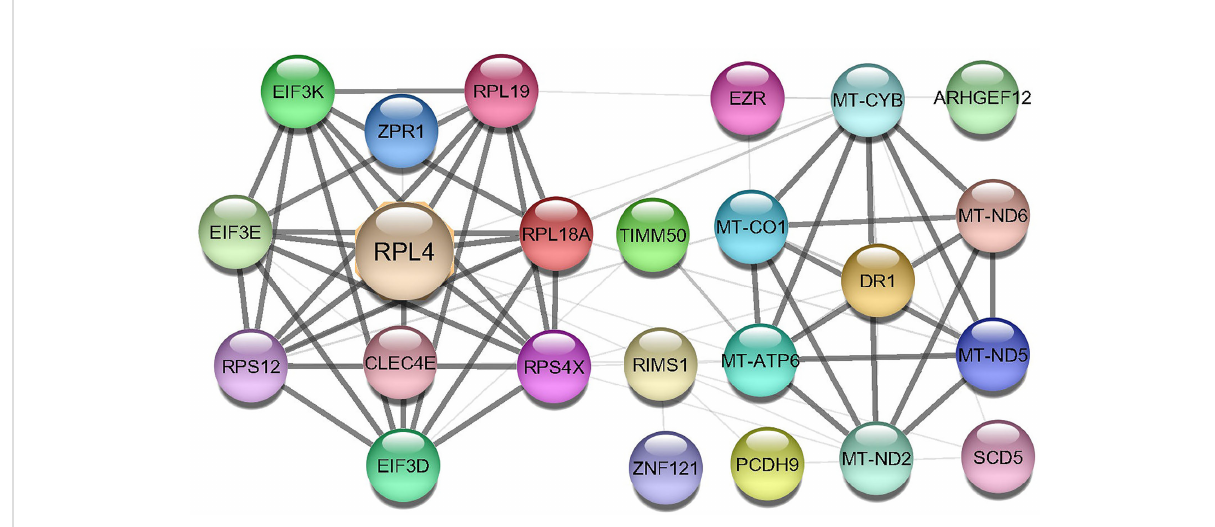
FIGURE 6 Protein-protein interaction (PPIs) network of common DEGs in COVID-19 patients. The nodes represent the proteins, and the edges represent the interactions across the proteins. Proteins having more edges are highly expressed, and thickness between the edges indicates the strength of interactions.